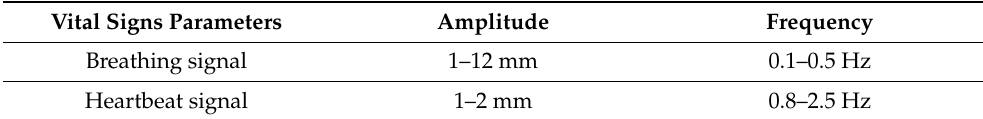
Table 1. Model of human life parameters [20–22]. Vital Signs